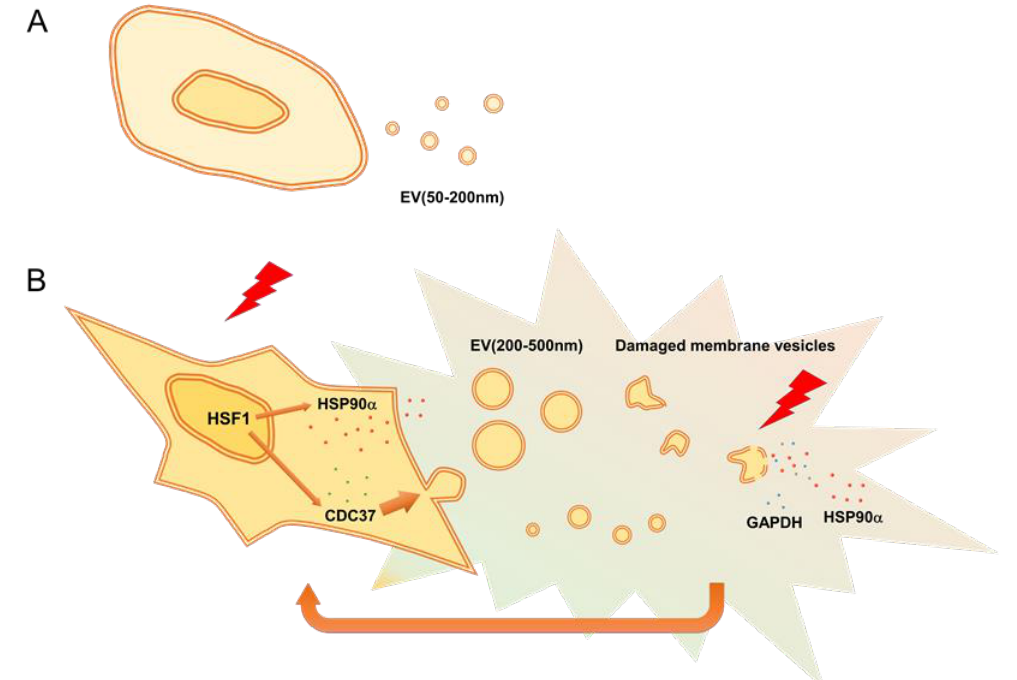
Figure 7. Graphical abstract. ( A ) Prostate cancer cells release EVs(50–200 nm) that contain HSP90α and transform normal epithelial cells by inducing EMT. ( B ) Cellular stress such as HSS activates HSF1, which induces the production of CDC37 and HSP90α via transcriptional activation (left). CDC37 is essential for proteostasis and the release of CD9-containing EVs. HSS for 1.5–3 h also triggers the production of larger EVs(200–500 nm) and membrane damage of EVs, from which HSP90α and GAPDH could be leaked. Therefore, we here define “stressome” as cell stress-induced all secretion products including EVs, membrane-damaged vesicles, and factors released from EVs and cells. Stressome may promote tumor progression.